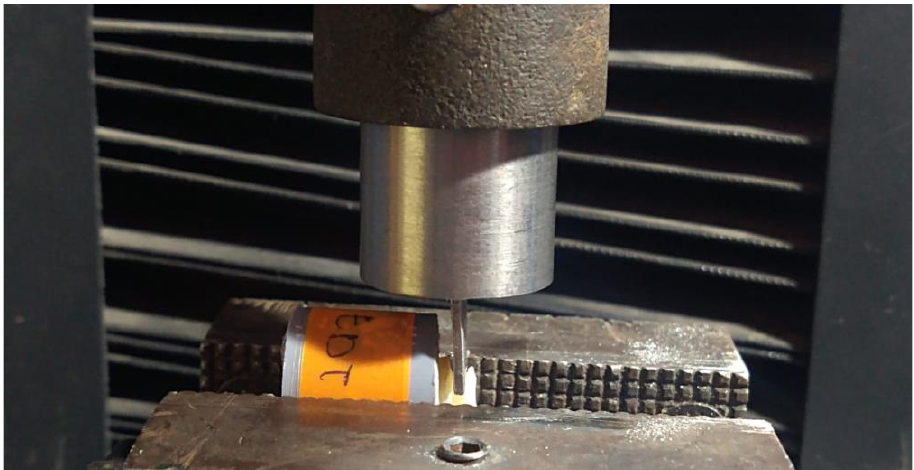
Figure 4. Shear test with universal testing machine.